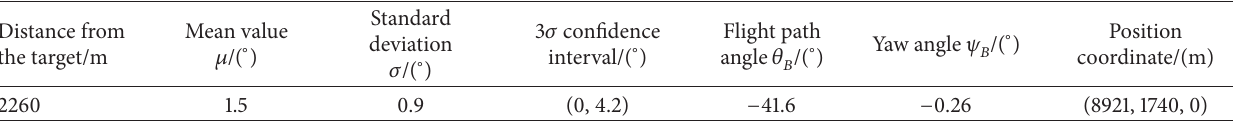
Table 5: The end point of midcourse guidance.